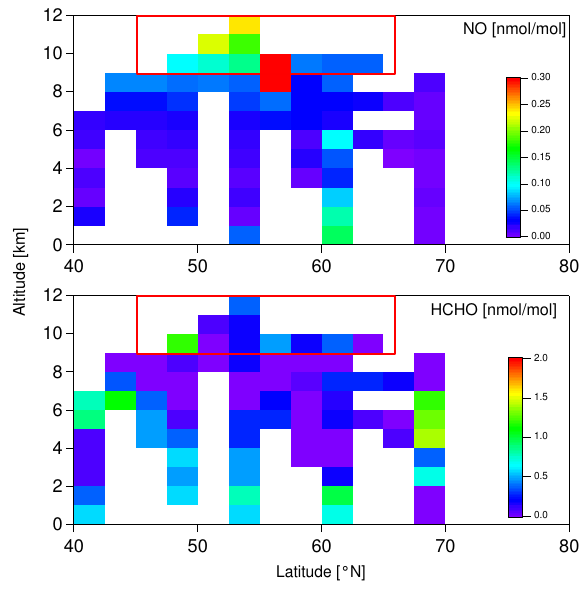
Fig. 4. Data maps for NO and HCHO during HOOVER 1 in October 2006. The red frame shows a positive correlation of NO with HCHO in the upper troposphere.